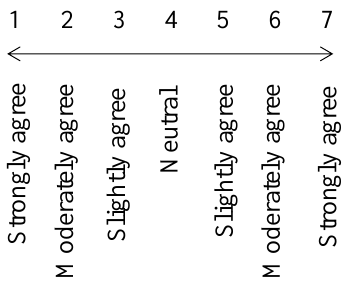
7 of 18 Figure 4. Examples of ( a ) power spectral density and ( b ) Poincaré plot, respectively. 2.4. Subjective Evaluation Experiment A subjective evaluation experiment was conducted to examine how each of the sub- jects perceived the same sounds. To measure the subjective human response to sound, various investigations have been conducted [37–40]. For example, the quality of various spaces such as room-acoustic spaces [37] and waterfront exterior spaces [38,39] are treated using psychological evaluations with subjective experiments. The relationship between the unpleasantness and tonality of sound has also been assessed using subjective evalua- tions. The room-acoustic impression is evaluated by using contrasting adjective pairs on a bipolar six-point semantic scale. Such an evaluation scheme is called an SD method, which was first introduced by Osgood [41]. This method is advantageous because of its easy-to-understand scaling and usage of popular adjectives. So, in the experiment, the SD method was used to evaluate subjective sound impressions. Many studies have used this method. For example, Yamada et al. used it [42] to spec- ify the subjective and objective effects of dental drill sounds on subjects. Like this study, the subjects were asked about their impression of the sound based on 15 paired adjectives. To evaluate the auditory impression of the contrasting sounds of white noise and mur- muring river sound, 15 pairs of bipolar adjectives were selected: beautiful–dirty; clear– dull; comfortable–uncomfortable; smooth–rough; moist–dry; sentimental–unsentimental; powerful–powerless; rich–poor; noisy–quiet; large–small; loud–calm; metallic–not metal- lic; high pitched–low pitched; hard–soft; and bright–dark. Using the selected 15 pairs of